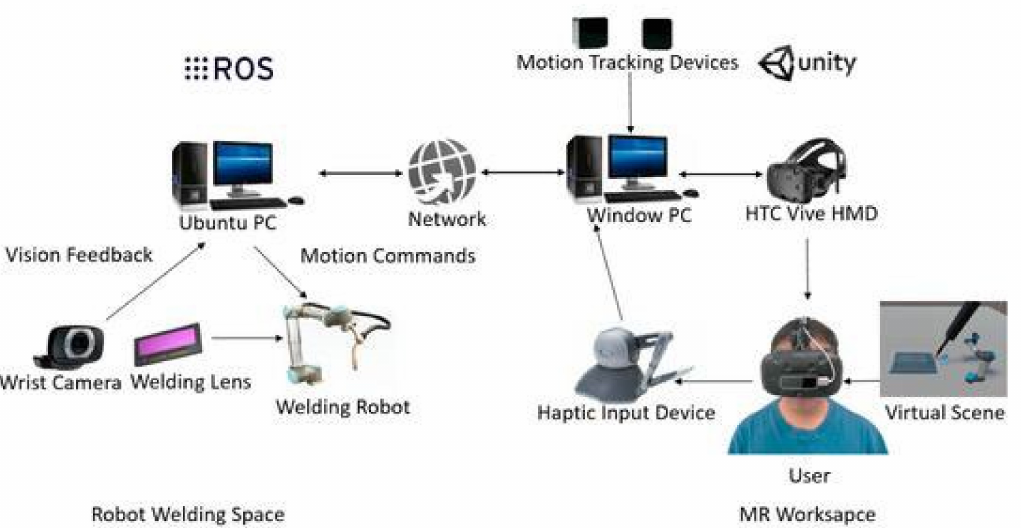
Figure 10. The communication scheme of the MRVF tele-welding hardware apparatus (reprinted from